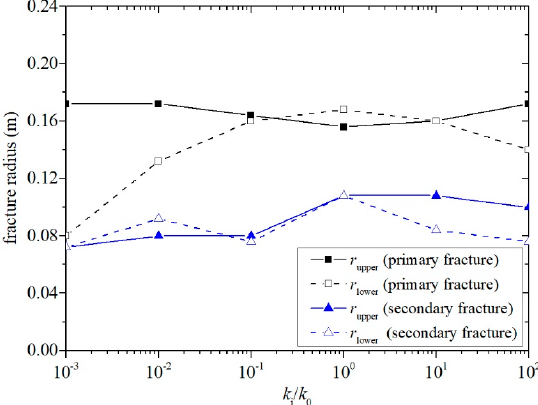
Figure 13. The fracture radius of models with different interlayer permeability at t = 2000 s (the primary fracture curves are redrawn from [67]).